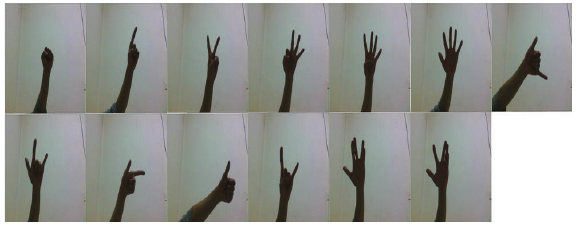
Figure 13: The image set of hand gestures used in the experiments. From left to right and then from top to bottom; these gestures are labeled as 0, 1, 2, 3, 4, 5, 6, 7, 8, 9, S1, S2, and S3.